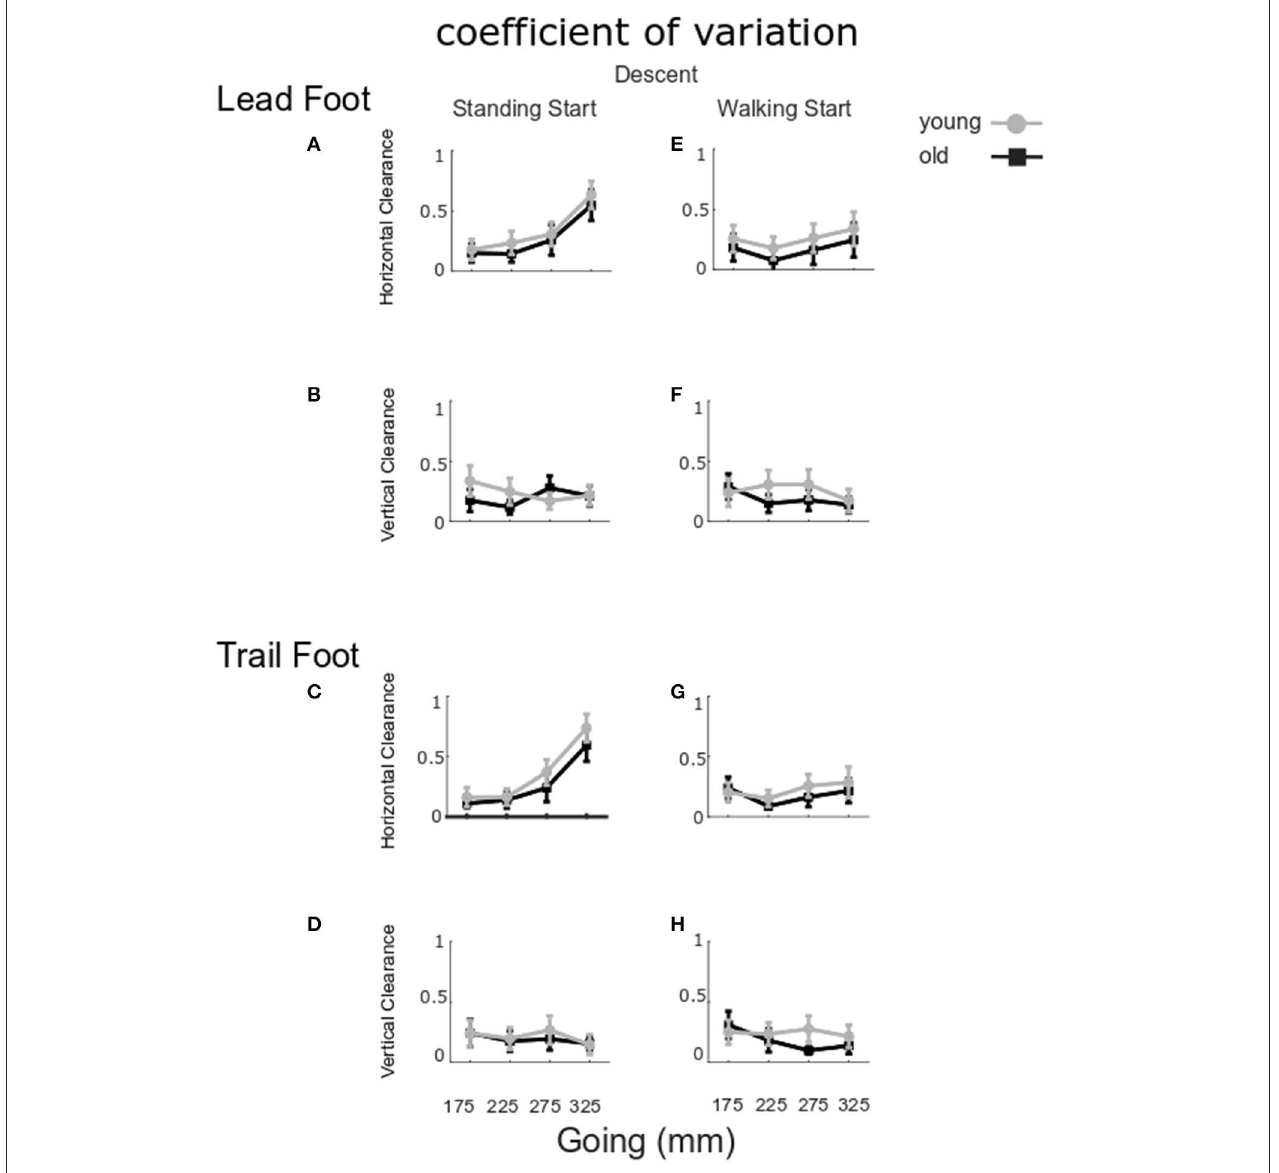
FIGURE 9 | Coefficient of variation for clearance in descent. The group mean and SE for older (black) and younger (gray) of the coefficient of variation for lead and trail foot horizontal (A,C,E,G) and vertical clearance (B,D,F,H) in stair descent at the four goings, from a standing (left column) and a walking start (right column).